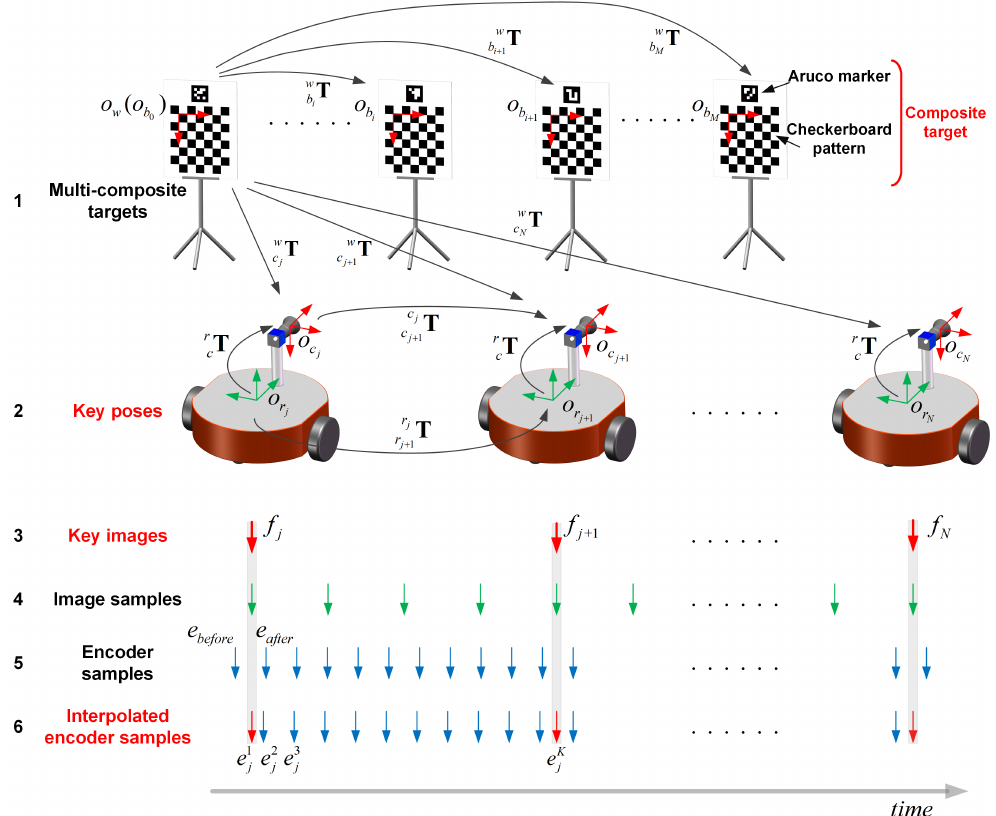
Figure 2. Schematic of automatic calibration